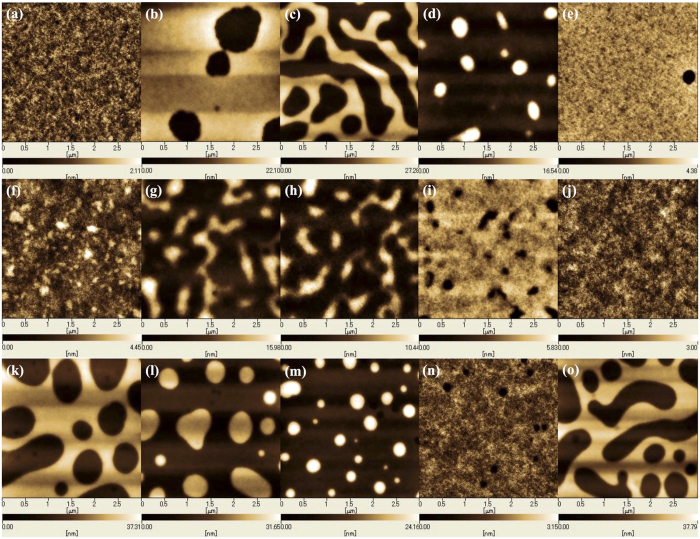
AFM height images of different thicknesses of PS100-b-PMHxOHS25 after annealing at 130 °C for 1 min(a–e) on PS-r-PMA, (f–j) on PMMA-r-PMA, and (k–o) on poly hydroxyethyl methacrylate (PHEMA). The PS100-b-PMHxOHS25 thicknesses were (a,f,k) 32 nm (=2.0L0); (b,g,l) 28 nm (=1.8L0); (c,h,m) 24 nm (=1.5L0); (d,i,n) 20 nm (=1.3L0); and (e,j,o) 16 nm (=1.0L0). Fingerprint patterns were observed for (f,i). No image was observed for the others.